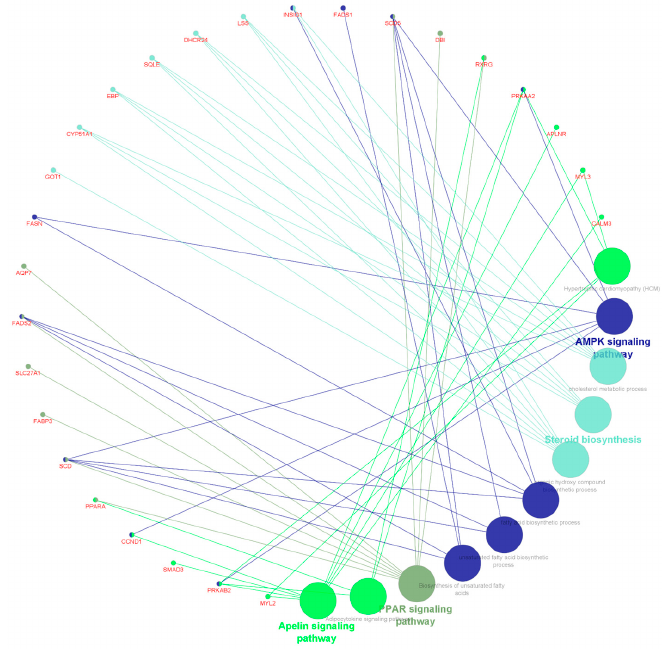
Figure 5. Circular network of shared upregulated DEGs in G2 at weaning between biological processes and KEGG pathways, which were highlighted in ORA and due to their potential relationship Metabolites 2023 , 13 , x FOR PEER REVIEW with intramuscular fat in cattle.